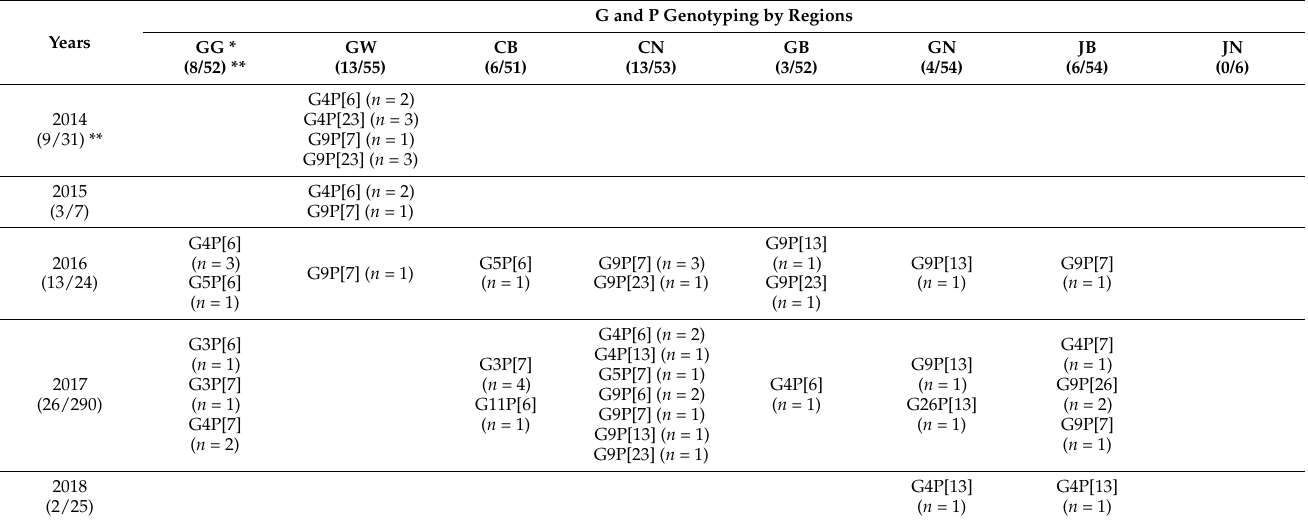
Table 2. G and P genotyping data for 53 Korean PoRVA-positive samples according to geographical region (2014–2018).